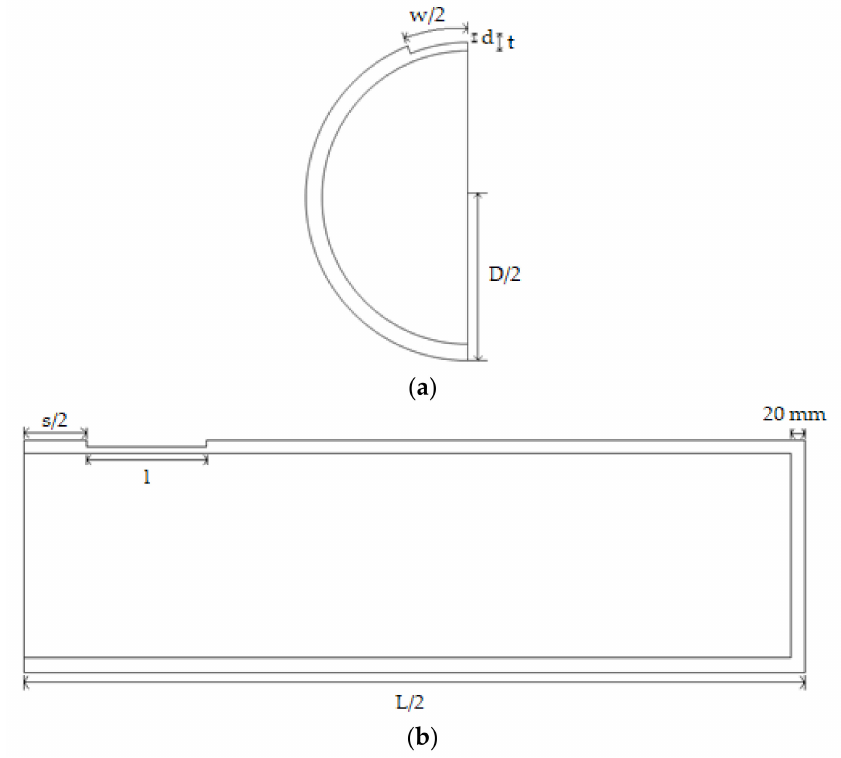
Figure 2. A quarter pipe model with longitudinally aligned interacting corrosion defects viewed from the ( a ) front ( b )